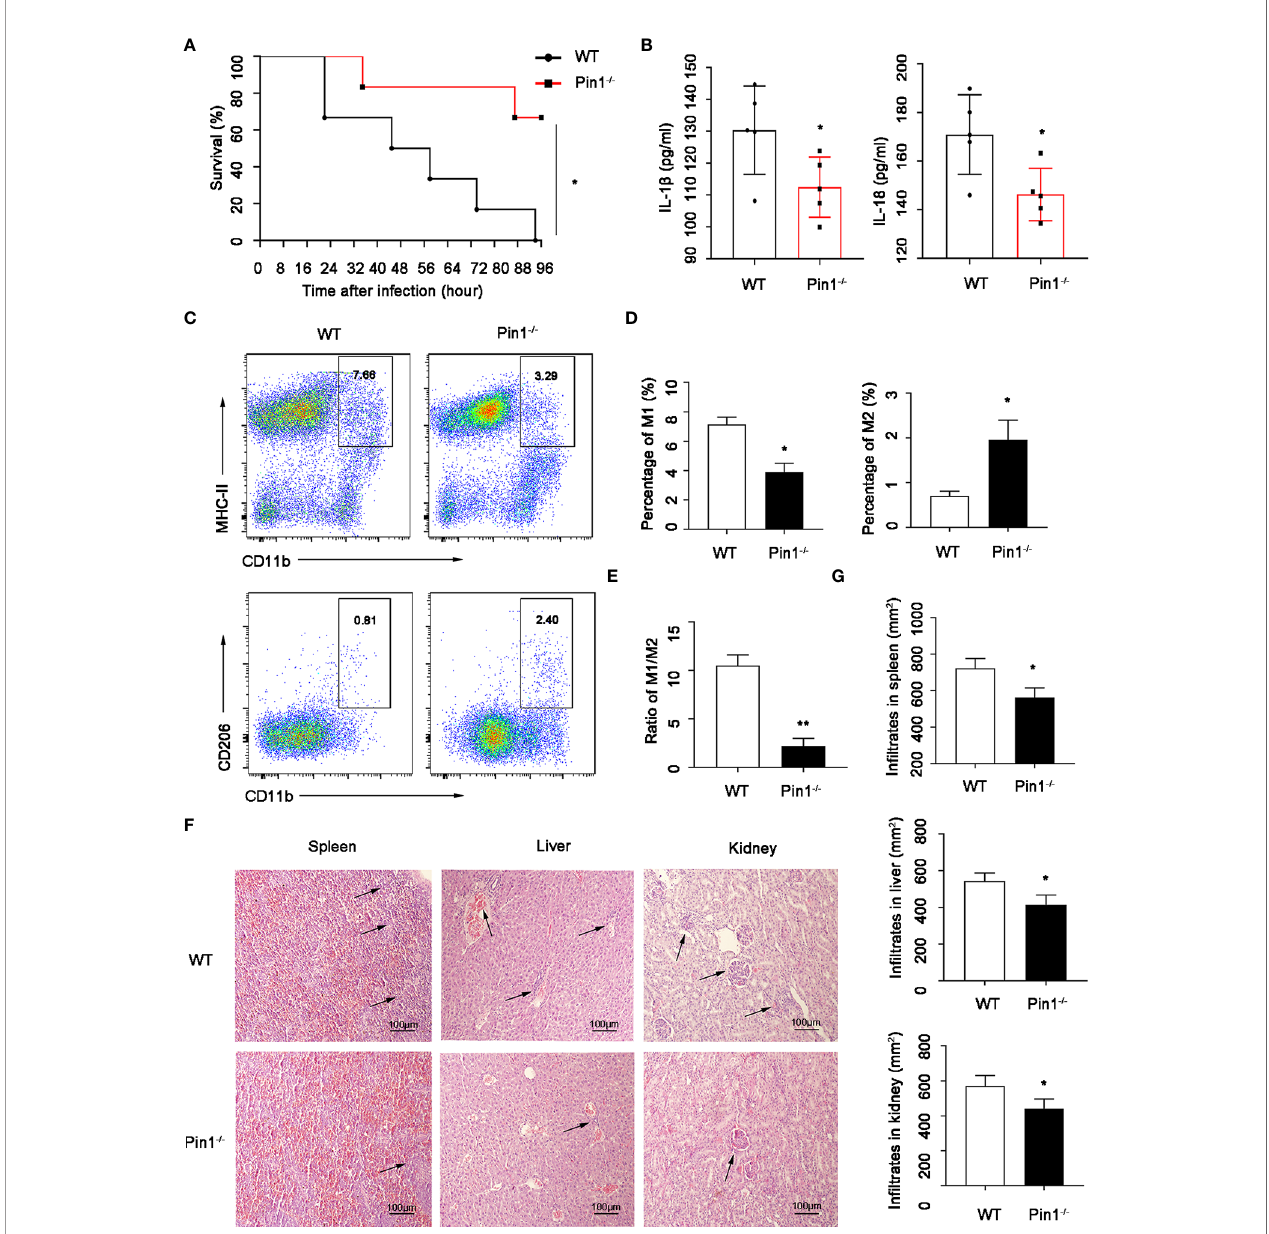
FIGURE 1 | Pin1 de fi ciency relieves lipopolysaccharide (LPS)-induced septic shock and organ damage. (A) Survival of WT mice (n=12) and Pin1 -/- mice (n=12) infected intraperitoneally with LPS (30 mg/kg of body weight). (B) The secretion of IL-18 and IL-1 b in the peritoneal lavage fl uid of WT mice (n=5) and Pin1 -/- mice (n =5) after intraperitoneal injection of LPS (30 mg/kg of body weight). (C) After intraperitoneal injection of LPS in WT mice (n=5) and Pin1 -/- mice (n =5), the proportions of M1 and M2 macrophages in the abdominal fl uid were analyzed by fl ow cytometry. (D) Quantitative analysis of the percentages of M1 and M2 macrophages in the abdominal fl uid of WT mice (n=5) and Pin1 -/- mice (n=5) treated with LPS. (E) The ratio of M1 and M2 macrophages in WT mice (n =5) and Pin1 -/- mice (n=5) treated intraperitoneally with LPS. (F) Histological analyses of spleens, livers, and kidneys from WT mice and Pin1 -/- mice. (G) Quantitative analysis of spleens, livers, and kidneys from WT mice and Pin1 -/- mice. The data represent the mean ± SD of one among three biological replicates, with three technical replicates each. *P < 0.05; **P < 0.01, log-rank test (A) , Student ’ s t test (B, D, E, G)